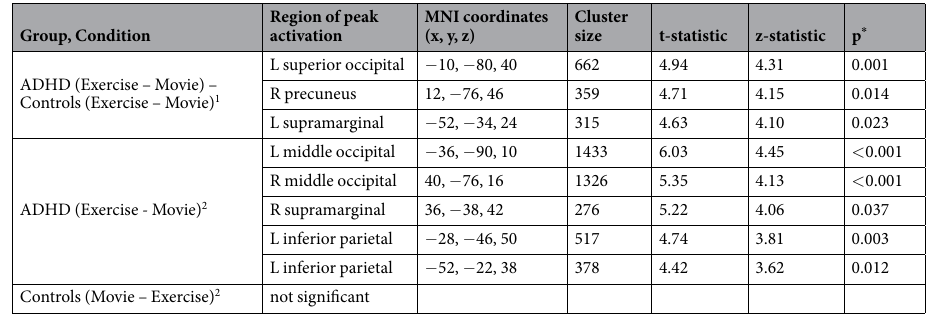
Table 3. Brain activation during correct inhibition trials of the Go/No-go task. * FWE-corrected on cluster level (initial voxel threshold 0.001 uncorrected); 1 two-sample t-test; 2 paired